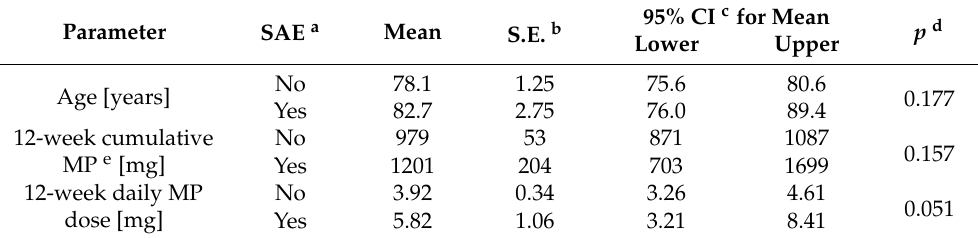
Table 5. Comparison of selected core clinical parameters of the n = 7 patients with a severe adverse event (SAE) with those of the rest of the patients without development of an